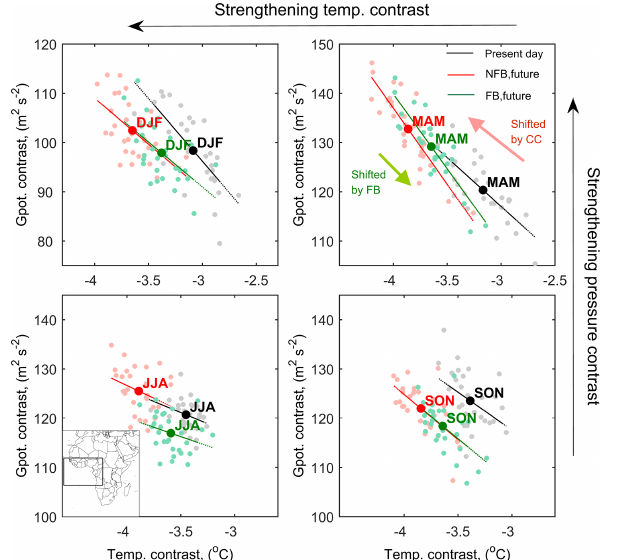
Figure 5. Changes in atmospheric ocean-land temperature contrast ( ∇ T ) and geopotential contrast ( ∇ ϕ ), represented by the mean con- trast at the three pressure levels 850, 925 and 975hPa (ocean minus land) within the domain 15 ◦ N–15 ◦ S, 24 ◦ W–20 ◦ E (see the inset in the panel for JJA), for the NFB and FB simulation in the present day and the future period (as defined in Sect. 2.2). Each scatter point represents the relation between ∇ ϕ and ∇ T for the corresponding season of one year, and the slopes represent its sensitivity during the selected